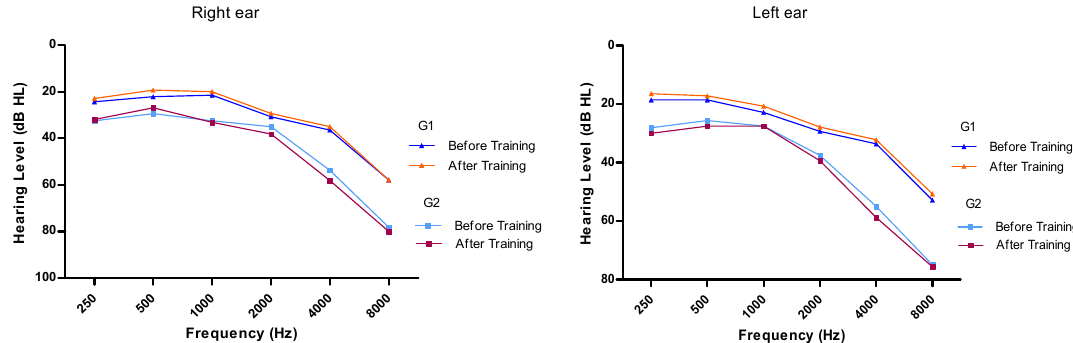
Figure 1. Average threshold obtained by frequency before and after auditory training in the right and left ears in group 1 (G1) and group 2 (G2).